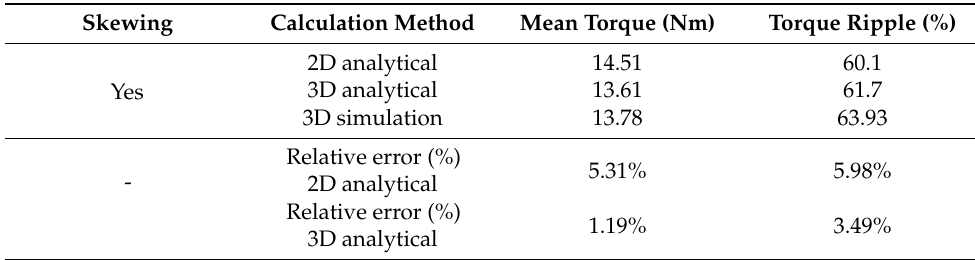
Table 4. Mean torque, torque ripple, and relative errors between for 2D and 3D superposition with respect to ASR-SRM 3D simulations.